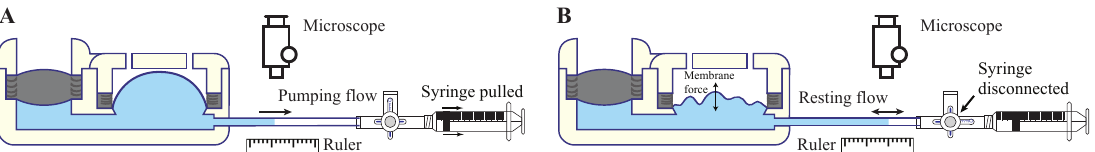
Figure 5. In vitro characterization of the microreservoirs was performed on 10 µ L microreservoirs (septum and storing area integrated) to evaluate performance for implantable and transdermal applications in simulated benchtop environments. ( A ) The storing area was filled through the septum. The fluid in the storing membrane was pumped via a vacuum created by pulling an empty syringe until 20% of the capacity was discharged. ( B ) The pumping vacuum was released, and the flow in the tubing due to membrane force was quantified under a microscope. The experiment was repeated for the next 20% of the overall